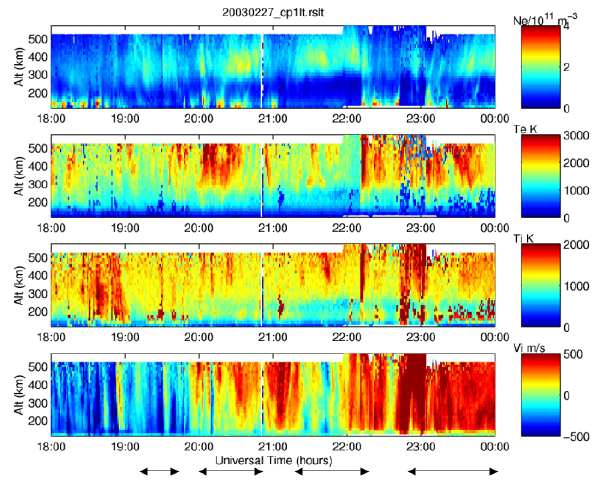
Fig. 7. (d) EISCAT N e , T i , T e and V data for the period 18:00– 24:00 UT on 27–28 February 2003. The periods of F-region inten- sifications of electron density are indicated by arrows.